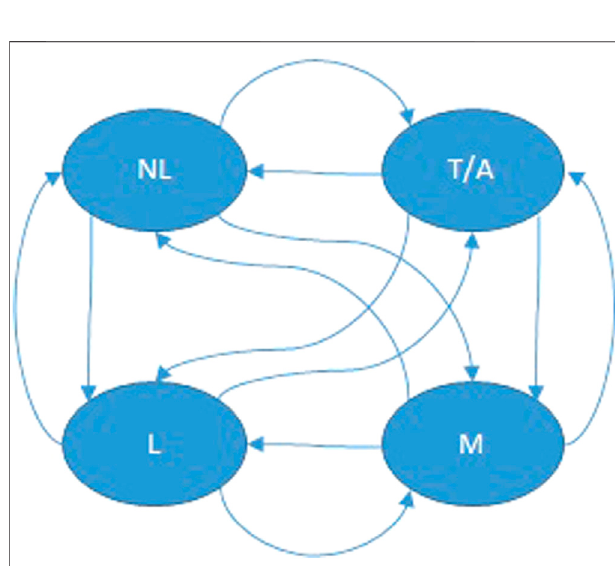
FIGURE 7 | MDP model for the game of chase between a mobile robot and an infant.